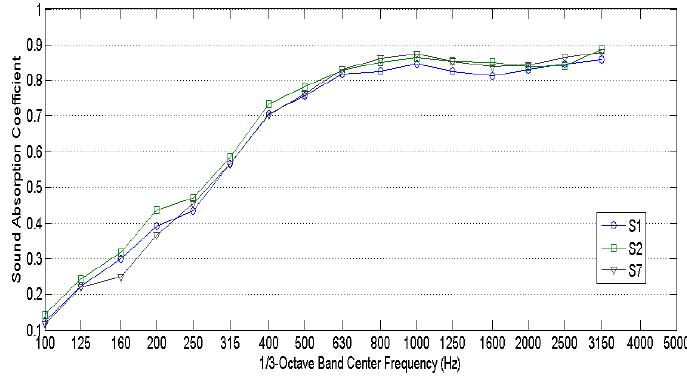
Figure 6. Measured diffuse field sound absorption coefficients of samples S1, S2, and S7.